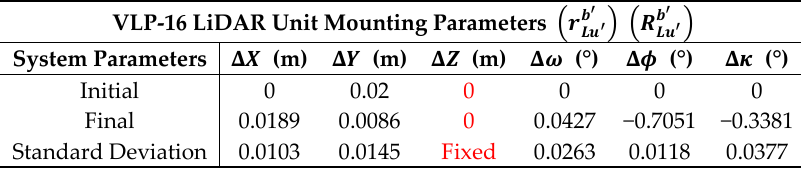
Table 6. Mounting parameters of VLP-16 before and after calibration test 3 (the parameter fixed during calibration is shown in red). Appl. Sci. 2018 , 8 , x FOR PEER REVIEW